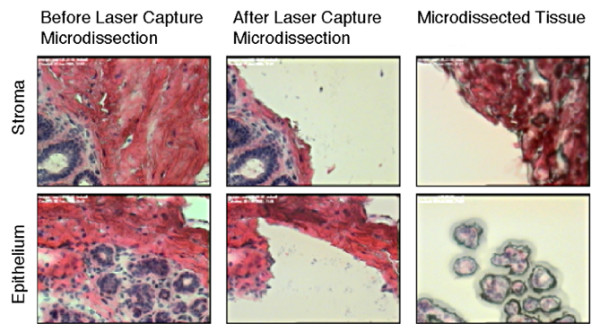
Laser-capture microdissection of epithelium and stroma from normal breast specimens. Frozen tissue sections (10 micron) stained with hematoxylin and eosin.